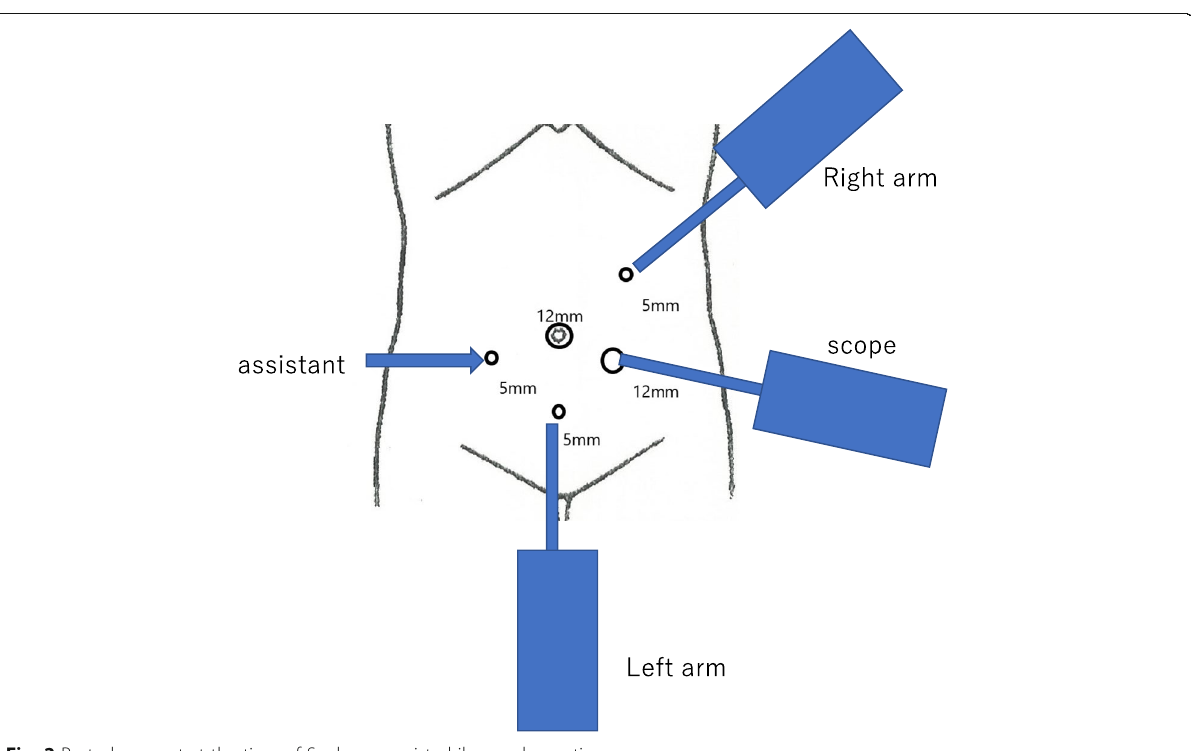
Fig. 2 Port placement at the time of Senhance-assisted ileocecal resection